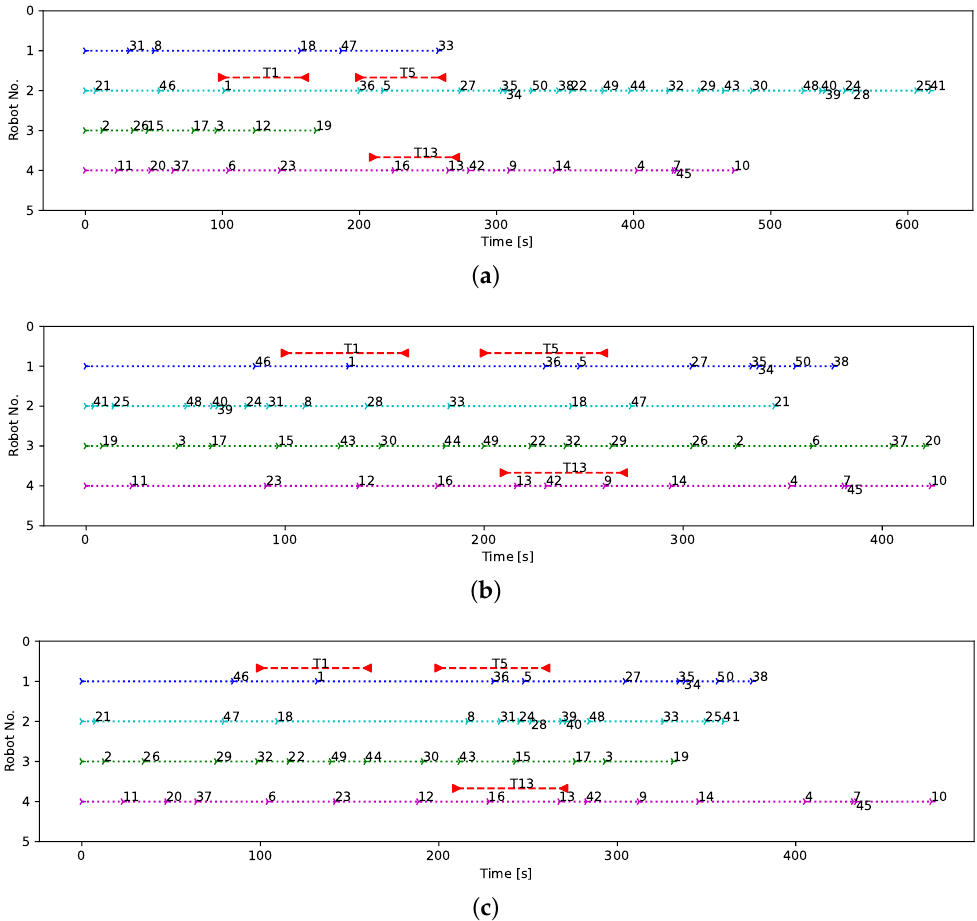
Figure 8. The time sequence the assigned tasks of each robot, ( a – c ) correspond to the three solutions sampled from Figure